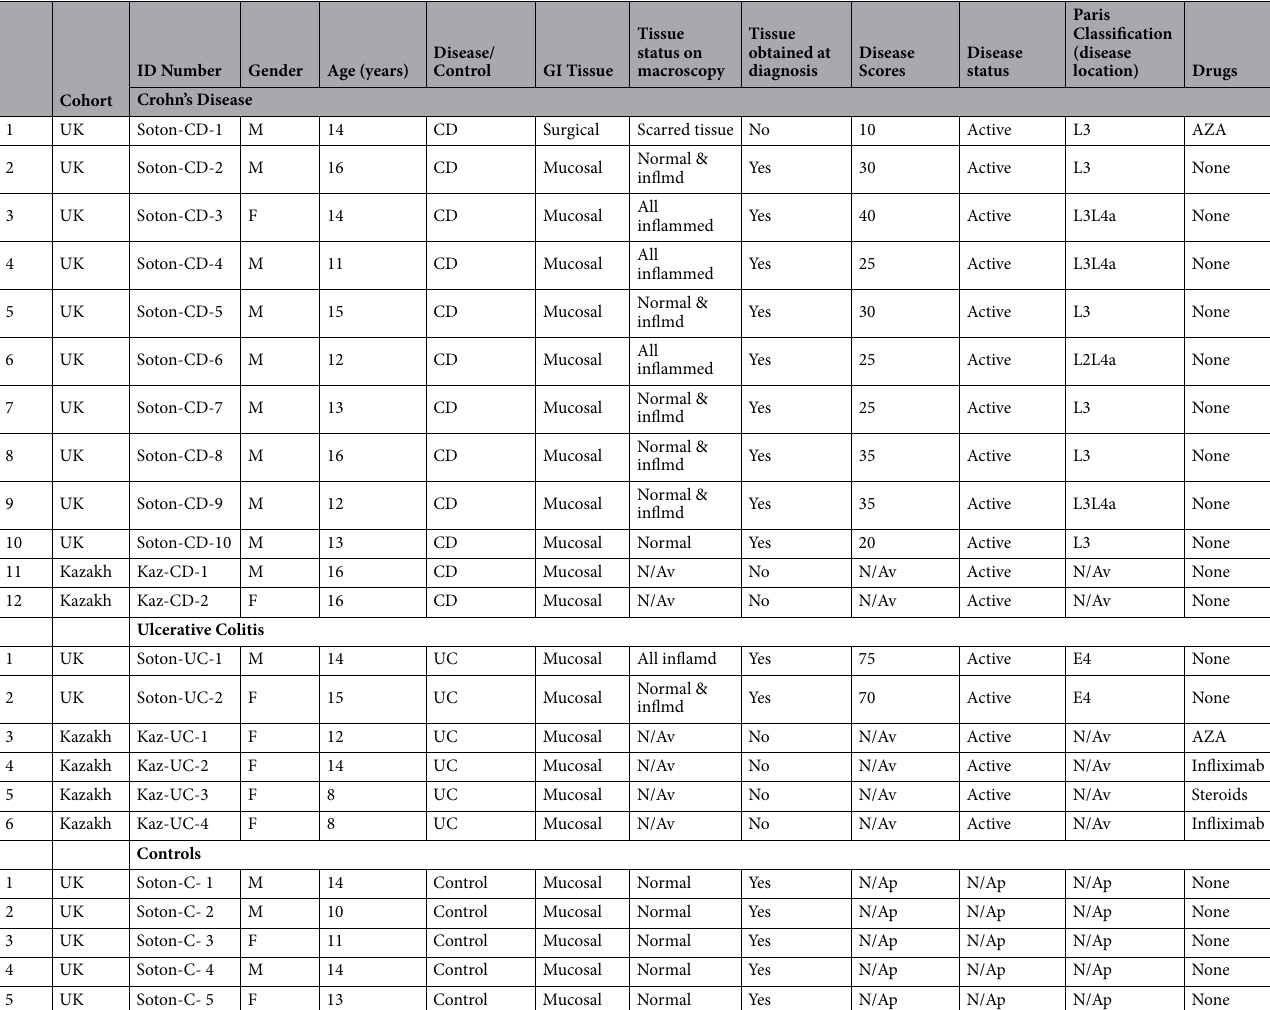
Table 2. Immuno-fluorescence staining for periostin: patients and controls. Immuno-fluorescence staining for periostin was performed in 23 individuals including 5 non-IBD controls. PUCAI or PCDAI are disease activity scores for UC and CD respectively at the time of tissue procurement. AZA—azathioprine. Disease location/s as per Paris classification for Crohn’s disease: L2 (colonic), L3 (ileo-colonic) & L4 (upper GI disease; L4a- proximal to the ligament of Treitz, L4b- distal to the ligament of Treitz); disease location E4 for UC indicates pancolitis. (Abbreviations: N/Av—Not available, N/Ap—Not